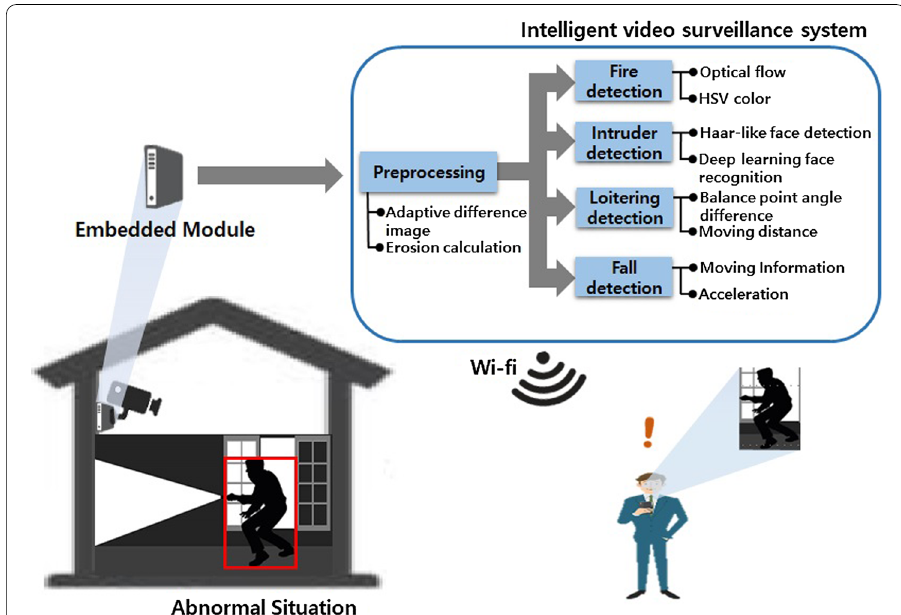
Fig. 1 Intelligent video surveillance system